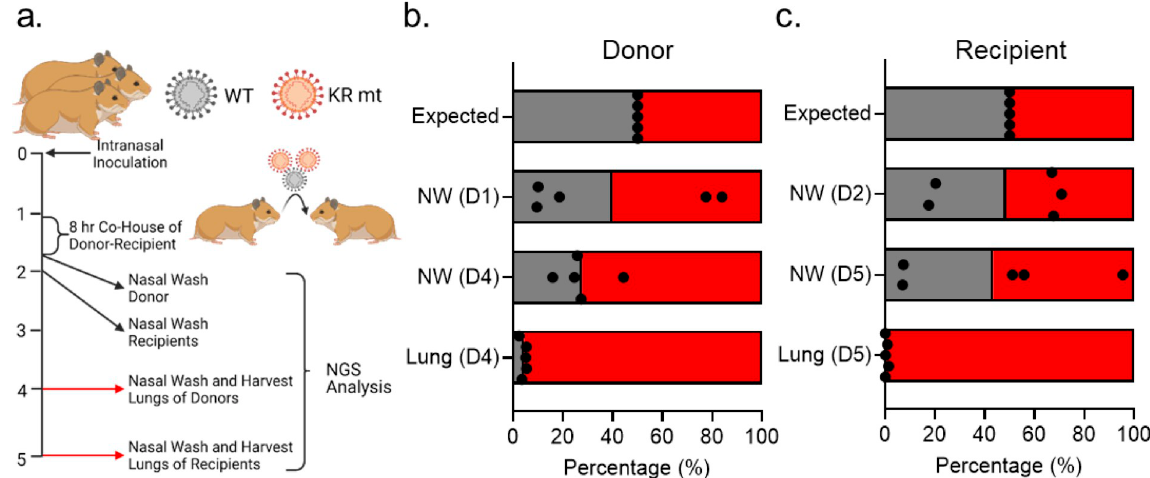
Fig 4. The KR mt enhances SARS-CoV-2 fitness in vivo . ( A ) Schematic of competition/transmission experiment. ( B-C ) Three- to four-week- old male donor hamsters were inoculated with 10 4 PFU of WT SARS-CoV-2 and the KR mt at a 1:1 ratio. On day 1 of the experiment, donor and recipient hamsters were co-housed for 8 hours, then separated, and the donor hamsters underwent nasal washing. On day 2, recipient hamsters were nasal washed. Hamsters were then monitored and nasal washes and lung tissue harvested on days 4 (donors) and 5 (recipients). The ratio of WT (gray) to KR mt (red) was then determined by NGS of all donor (B) and recipient (C) samples. Individual replicates are graphed as points, while bars represent the mean. Schematic in (A) generated using